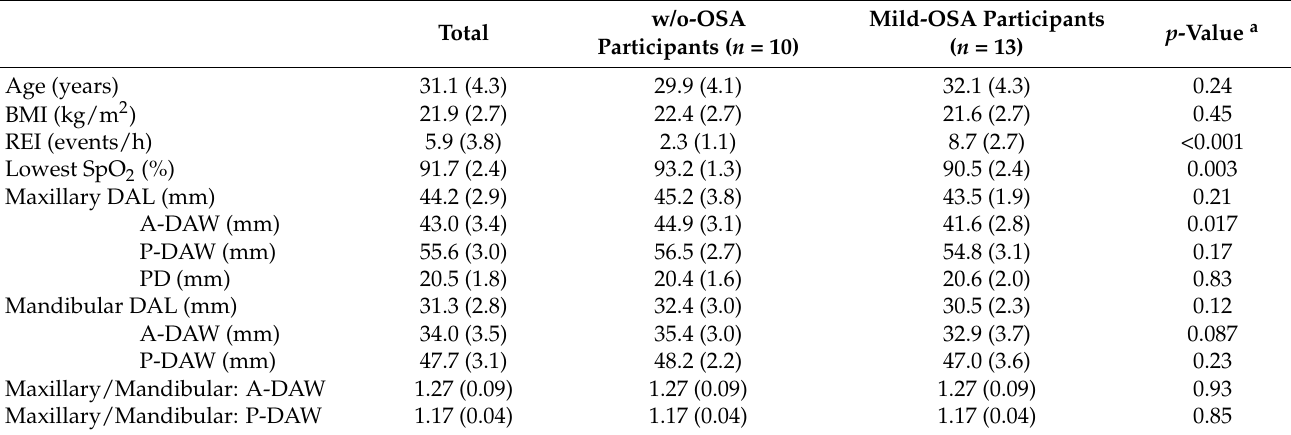
Table 1. Participant characteristics of the w/o-OSA and mild-OSA at